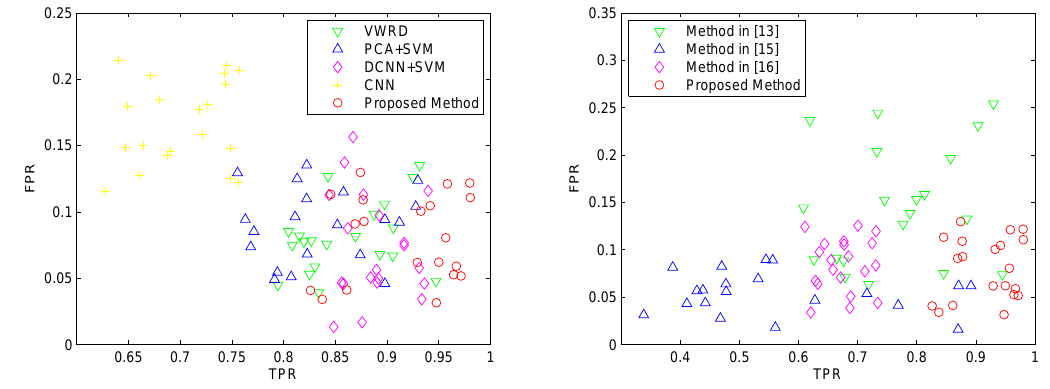
Figure 7. The results of different methods for urban area detection on the DigitalGlobe dataset, where each scatter point indicates a pair of TPR and FPR. Left: Performance comparison of the proposed method and supervised compared methods. Right: Performance comparison of the proposed method and unsupervised compared methods. Our method (red circles, bottom right corner) has the best TPR and FPR overall.